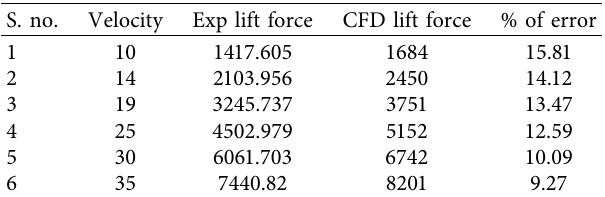
Table 9: Validation of HH02 rotor.